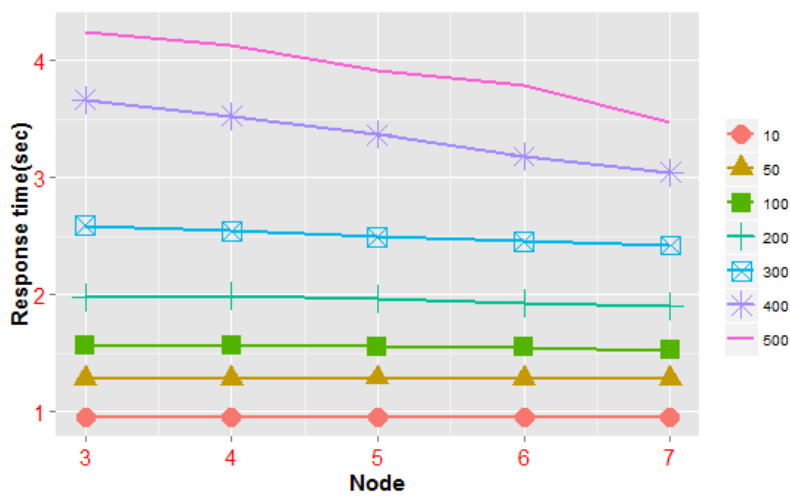
Figure 19. Response time of concurrent tile requests by different quantities of processing nodes.